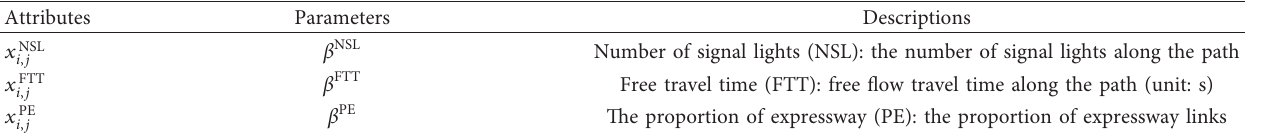
Table 2: Attributes used for path utility.